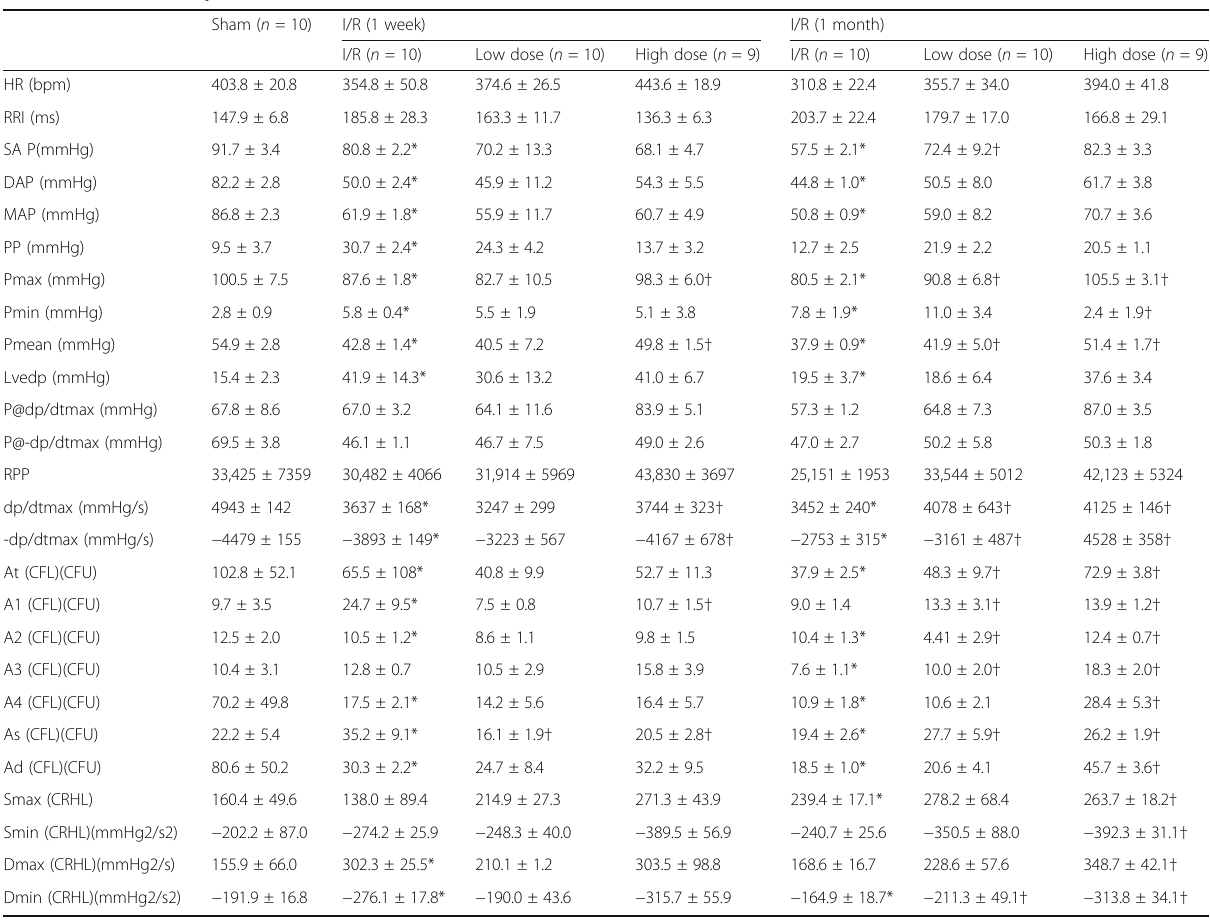
Table 2: cardiac function parameters. HR (Heart rate), RRI (the R-R interval), SAP (Systolic arterial pressure), DAP (Diastolic arterial pressure), MAP (Mean arterial pressure), PP (Pulse pressure), Pmax (the maximum of left ventricular pressure development), Pmin (the minimum of left ventricular pressure development), Pmean (the mean of ventricular pressure development), LVEDP (left ventricular end-diastolic pressure), P@dp/dtmax (the left ventricular pressure corresponding to the rates of maximum positive left ventricular pressure development), P@-dp/dtmax (the left ventricular pressure corresponding to the rates of maximum negative left ventricular pressure development), RPP (rate pressure product), +dp/dtmax (rates of maximum positive left ventricular pressure development), − dp/dtmax (rates of maximum negative left ventricular pressure development), CFL (cardiac force loop), At(CFL) (total area of CFL), A1(CFL) (area of the first CFL), A2(CFL) (area of the second CFL), A3(CFL) (area of the third CFL), A4(CFL) (area of the fourth CFL), As(CFL) (systolic area of CFL), Ad(CFL) (diastolic area of CFL), CRHL (contraction relaxation harmoniousness loop), Smax (CRHL) (the maximum of positive left ventricular systolic pressure of d 2 p/dt 2 ), Smin (CRHL) (the maximum of negative left ventricular systolic pressure of d 2 p/dt 2 ), Dmax (CRHL) (the maximum of positive left ventricular diastolic pressure of d 2 p/dt 2 ),Dmin (CRHL) (the maximum of negative left ventricular diastolic pressure of d 2 p/dt 2 ) were measured by a cardiac function analysis system. Values were expressed as mean ± S.E.M. Sham: Sham group; I/R: ischemic/reperfusion group. Low dose: I/R + (1 ml) MYQ treatment group. High dose: I/R + (4 ml) MYQ treatment group. * P < 0.05 compared with sham group. † P < 0.05 compared with I/R